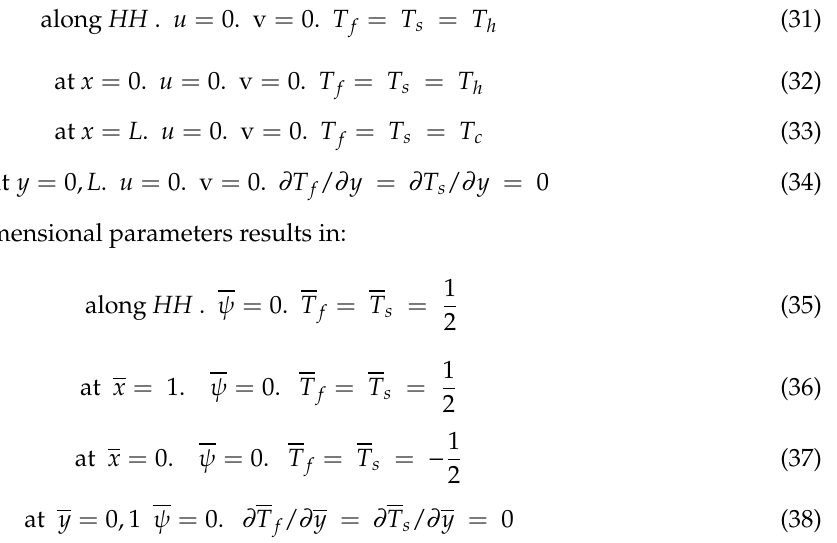
Figure 18. Nusselt number at H = 5 , HH = 25% , Kr = 1 , Rd = 0 for strip at 5.0